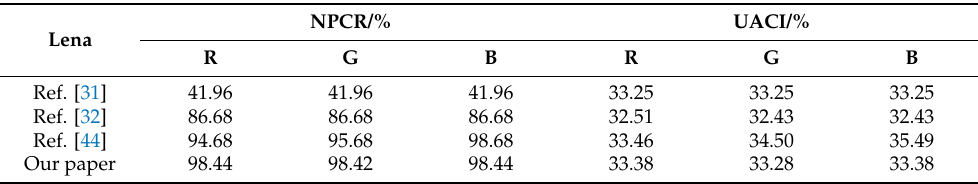
Table 4. NPCR and UACI values for ciphertext images.